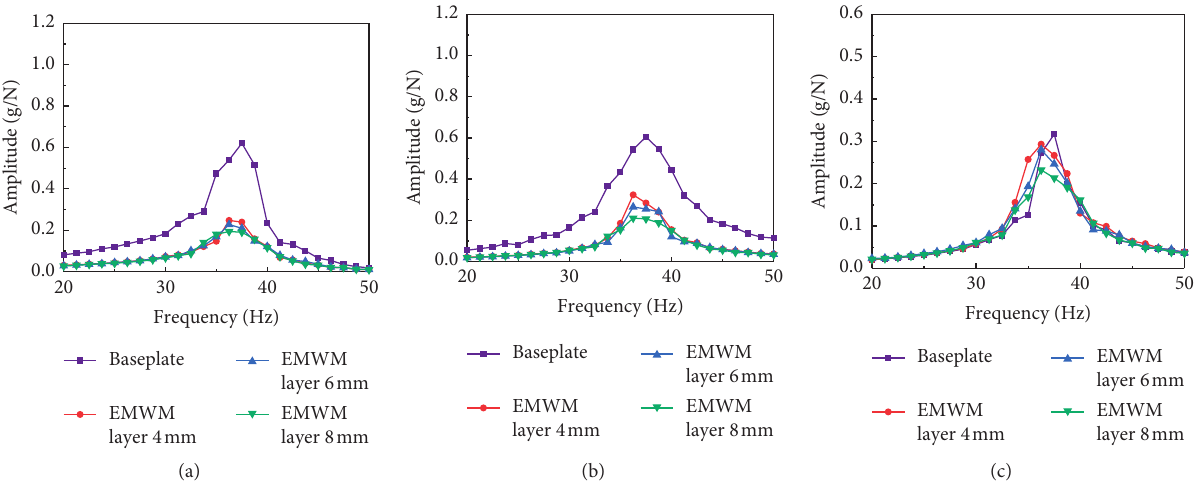
Figure 14: The FRCs of the baseplate and composite structures at 1 st -order modal frequency under different boundary conditions (D1). (a) C-C-F-F, (b) C-C-C-F, and (c)